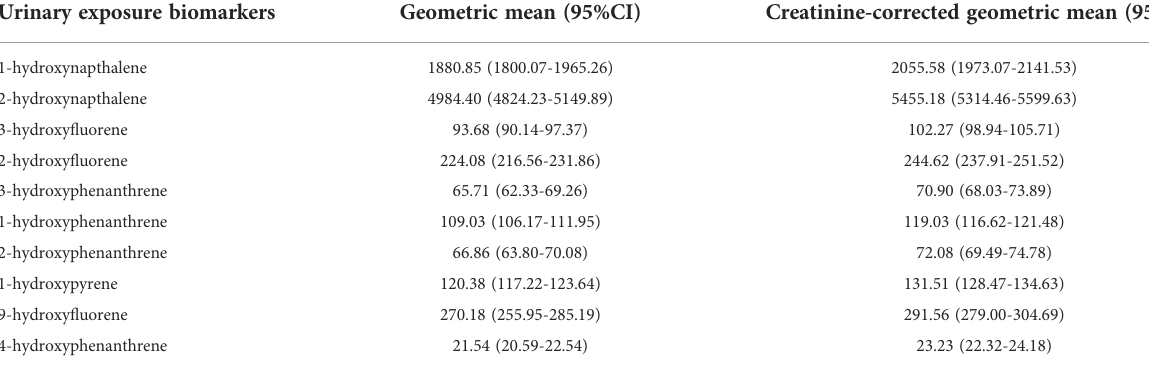
TABLE 2 Distribution of urinary PAH metabolites among 4,654 subjects. Urinary exposure